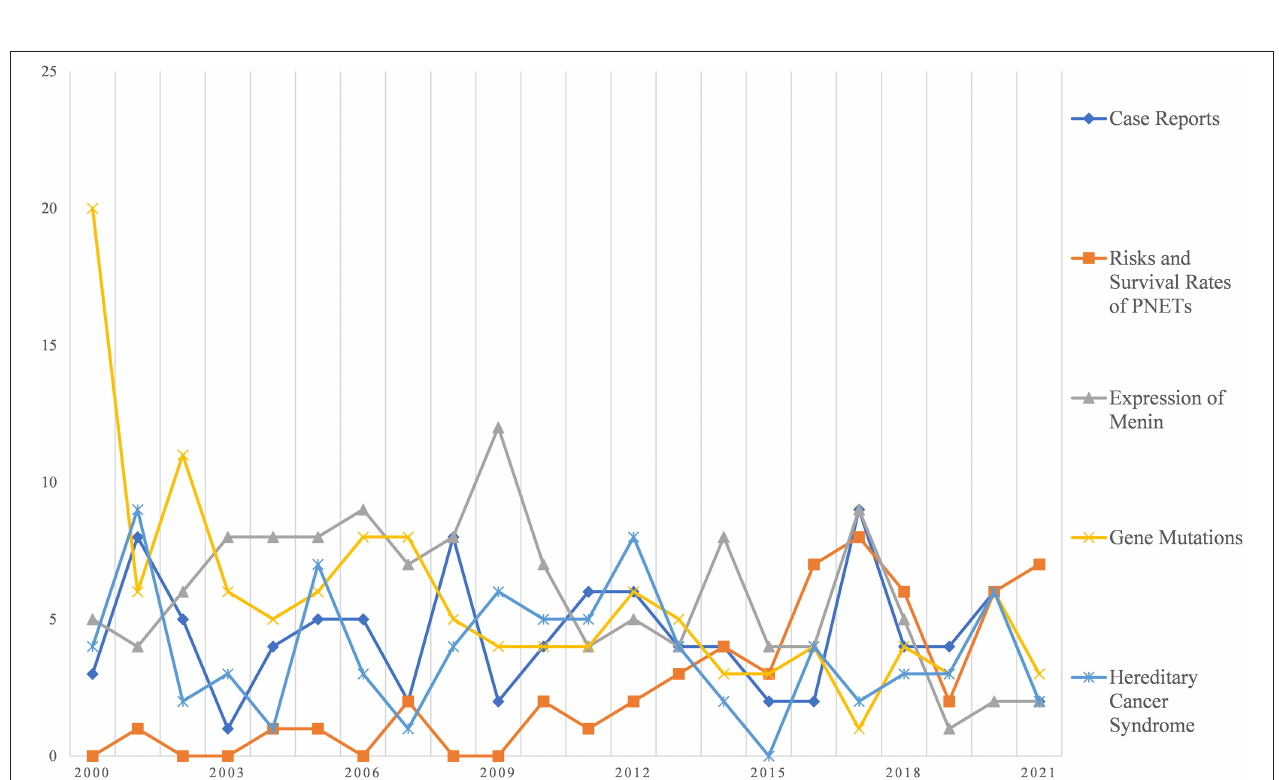
FIGURE 5 | Latent Dirichlet allocation (LDA) analysis: top 5 topic areas in late 22 years.